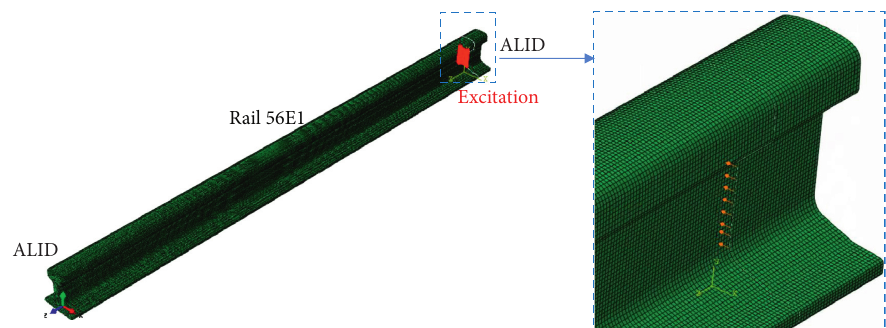
Figure 4: FE model for wave propagation in a